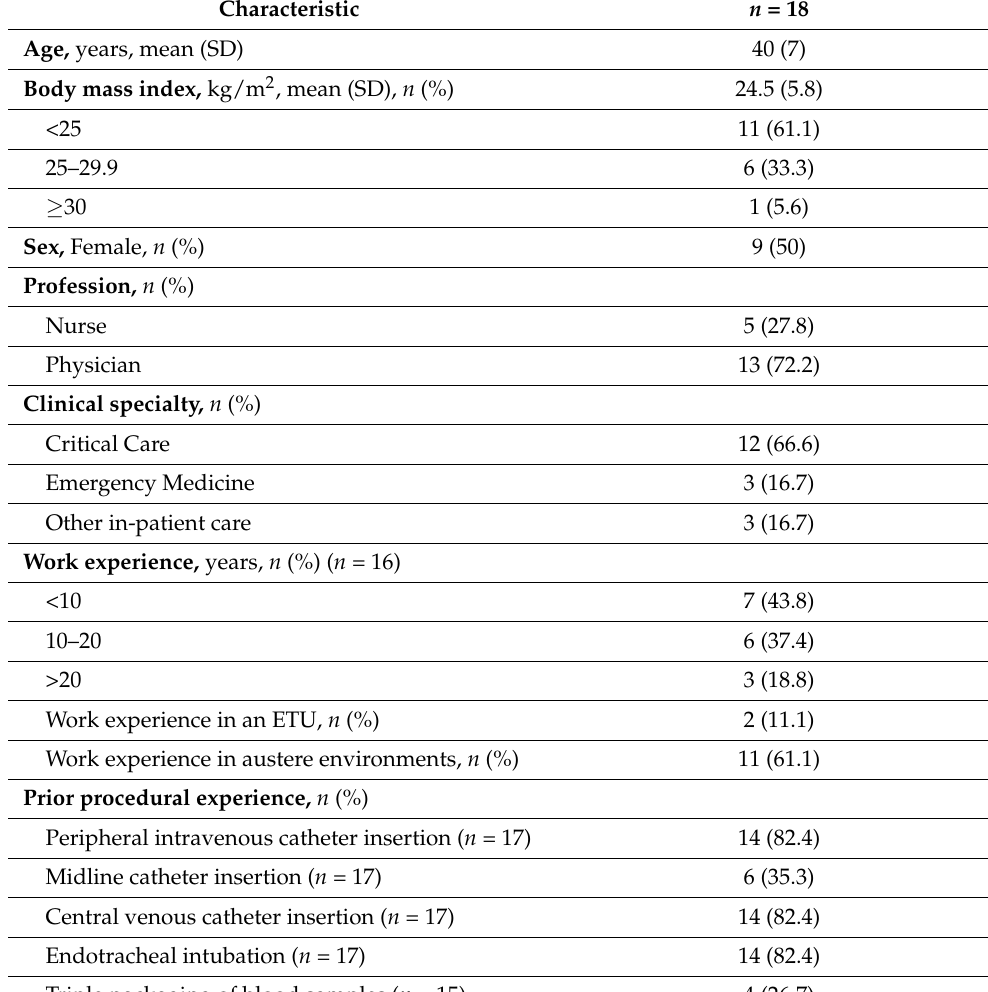
Table 1. Participant demographics and baseline